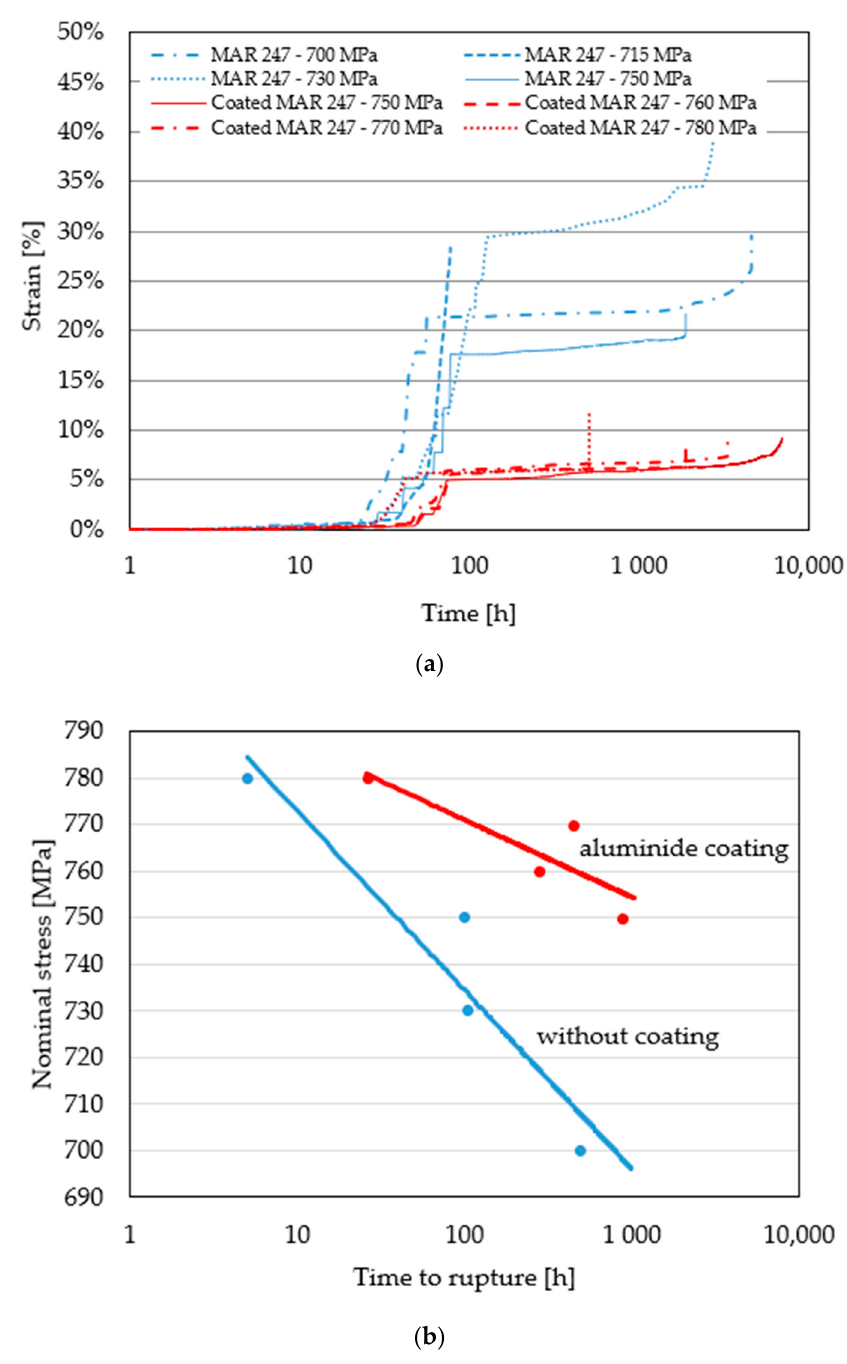
Figure 7. Creep characteristics of coated and uncoated MAR 247 nickel based superalloy ( a ); effect of stress level on time to rupture of coated and uncoated MAR247 nickel based superalloy subjected to creep at 600 °C ( b ).